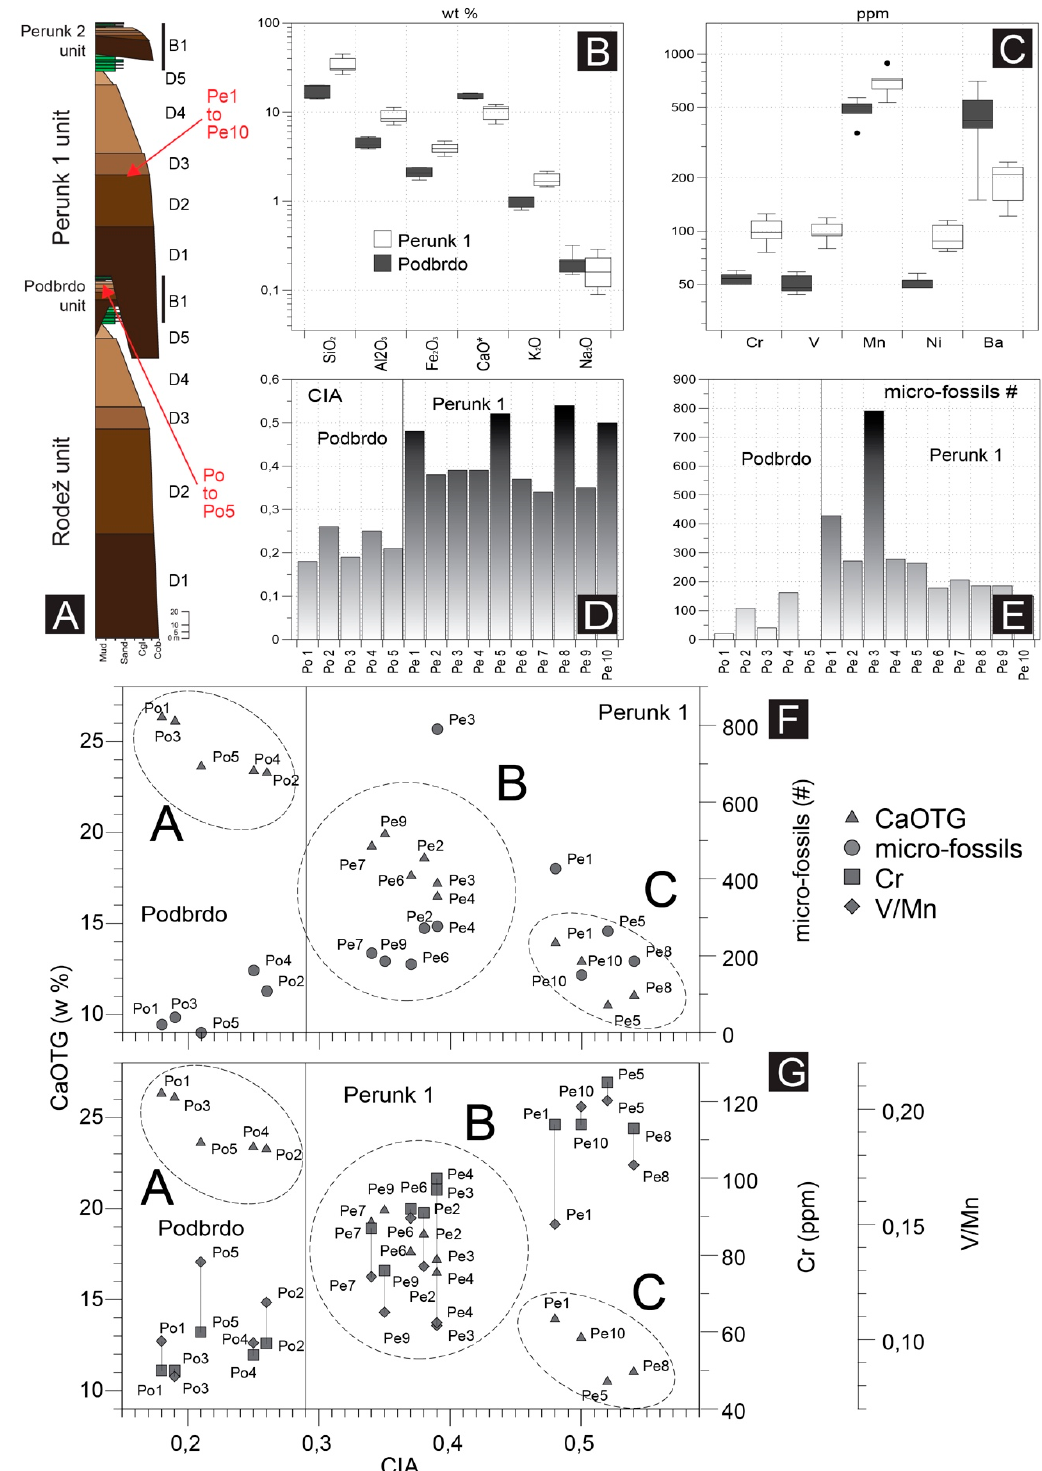
Figure 4. Summary of geochemical data. ( A ). Simplified stratigraphic column of Figure 2A with location of the samples used for geochemical analyses. ( B ). Whiskers plots of major XRF elements. ( C ). Whiskers plots of trace XRF elements. ( D ). Histogram of calculated CIA values per sample. ( E ). Histogram of the number of preserved nannoplankton microfossils per sample (Pogaˇcnik, unpublished data). ( F ). Relationships between CaO, CIA and the number of nannoplankton microfossils. Ratio between the CIA and the number of nanoplankton microfossils with the absolute carbonate content determined by TG methods. ( G ). Relationship between Cr, CaO, the V/Mn ratio and CIA.